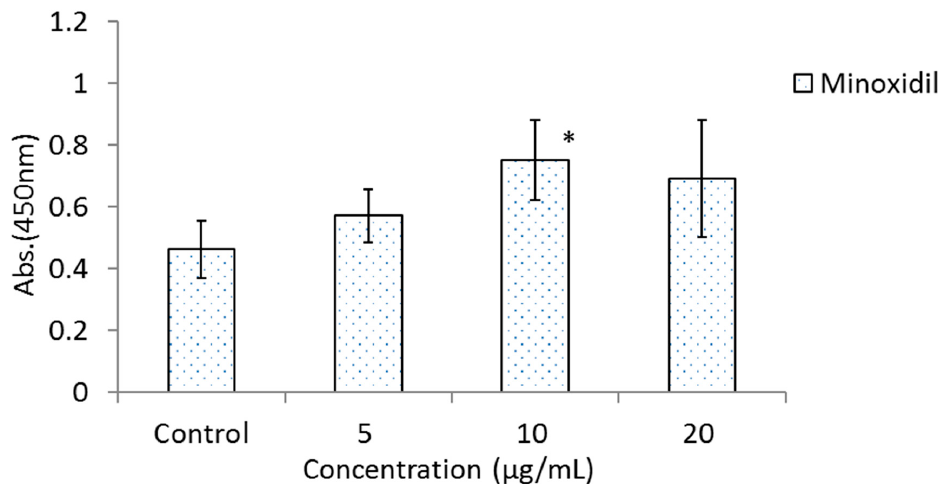
Figure 3. Effects of BOLE, HGPEE, HGPWE and minoxidil on the number of human fetal epidermal keratinocytes in a two-layer culture of human hair papilla cells and human epidermal keratinocytes. n = 4, mean ± S.D. * p < 0.05 vs. Control, + p < 0.1 vs. Control.